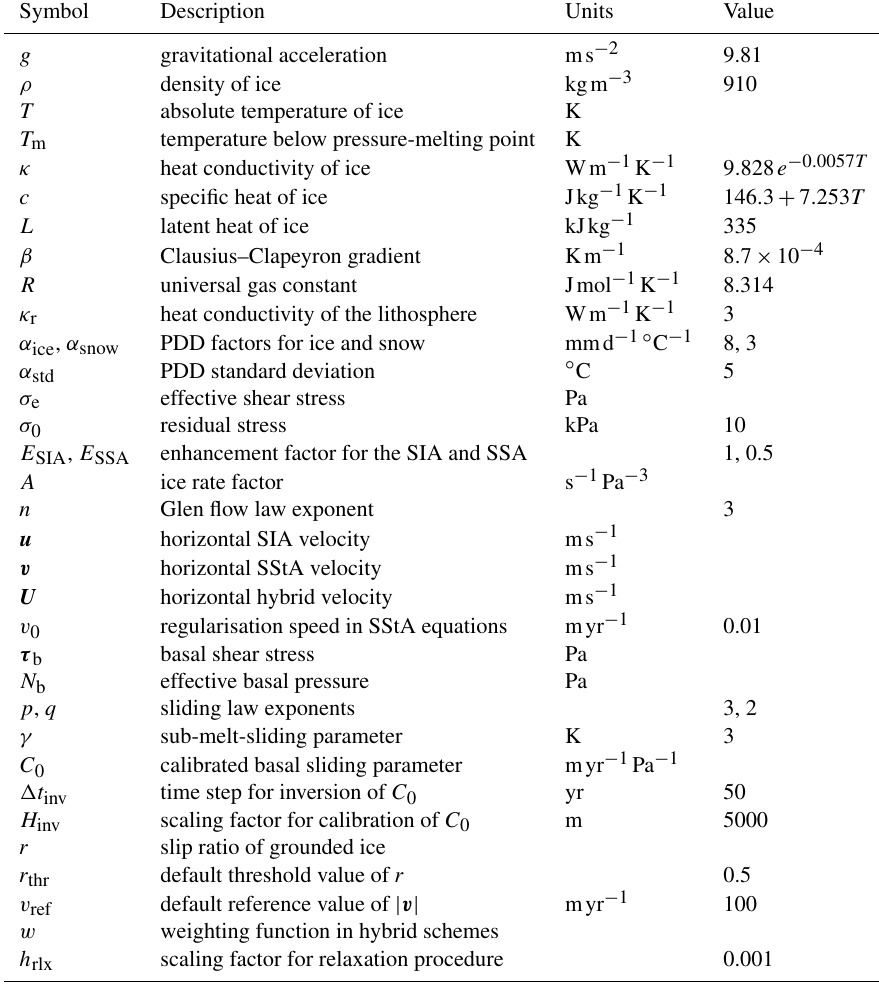
Table 1. Symbols and values for the model parameters used in this study.